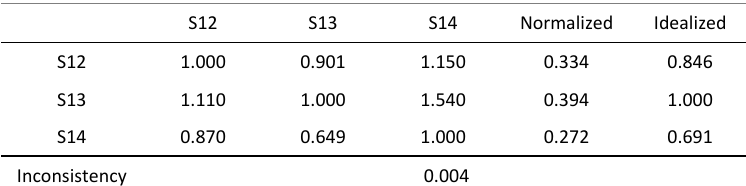
Table 7. Pairwise comparison matrix of marketing sub-criteria Table 7: Pairwise comparison matrix of marketing sub-criteria